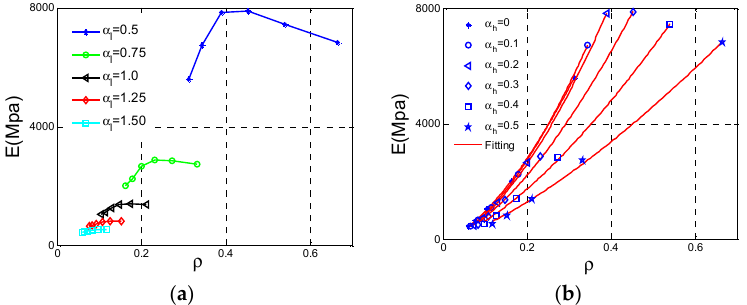
Figure 16. The changes of effective Young’s modulus E for Type D cell with respect to the relative density ρ : ( a ) data set; ( b ) fitting curves.